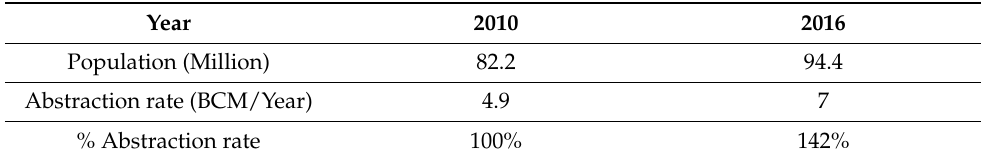
Table 4. Land subsidence model calibration